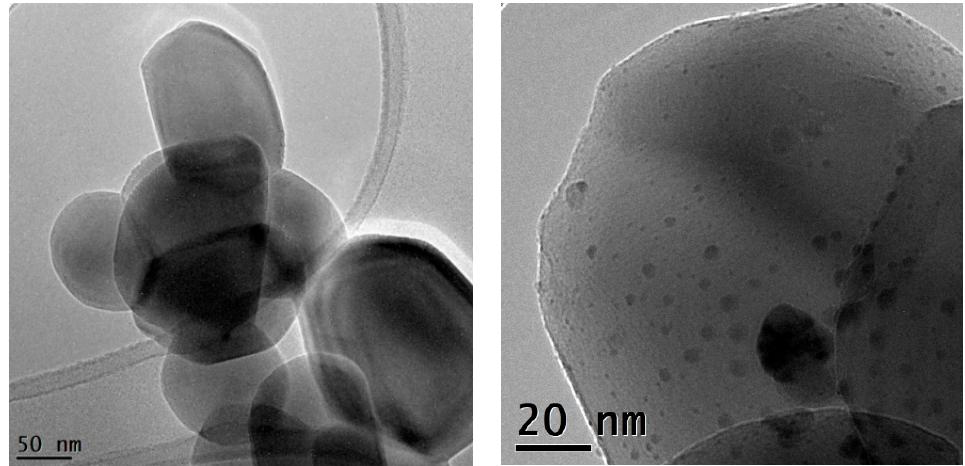
Figure 4. TEM micrographs recorded at a 43 K magnification and 145 K magnification of the 3%Ag- TiO 2